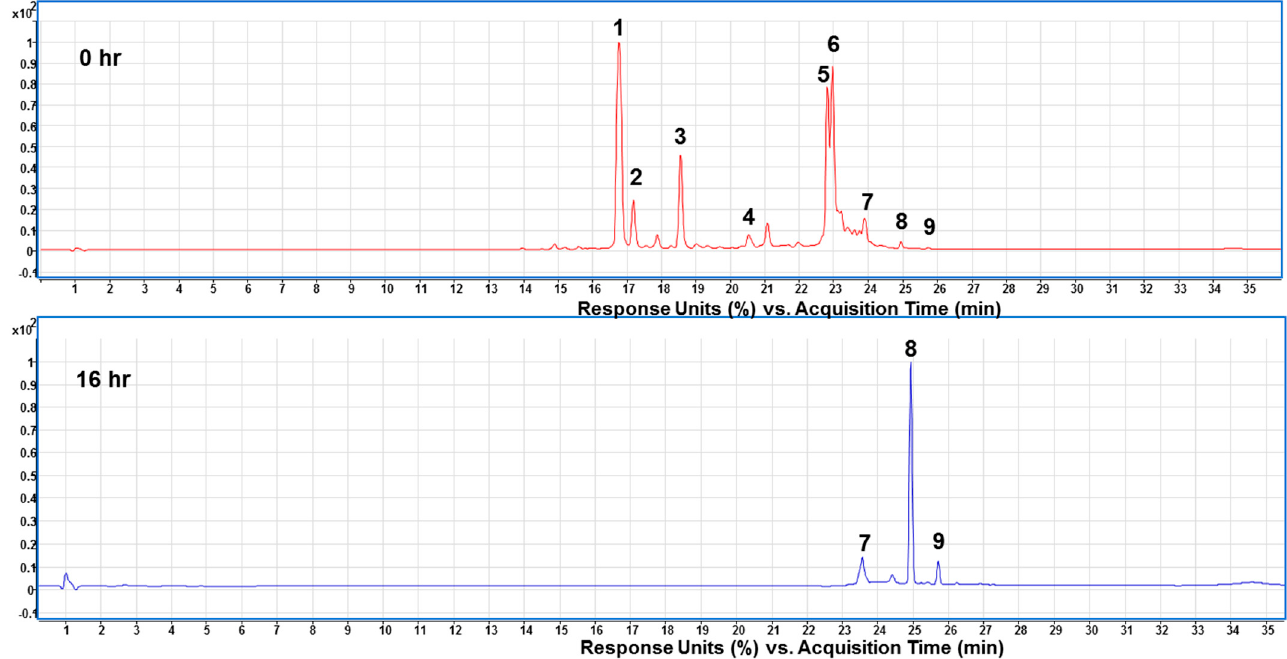
Figure 5. HPLC profiles for the bioconversion of crocins extracts using Celluclast ® 1.5 L enzymes detected at 440 nm in the incubation time of 0 and 16 h. HPLC parameters: C18 column (1.8 μ m, 2.1 × 100 mm; Agilent Eclipse Plus) column oven 35 °C, mobile phases ( A ) 0.1% formic acid in water and ( B ) acetonitrile (containing 0.1% Formic acid) at 0.3 mL/min. DAD: 440 nm. Peak numbers are referred to Table 3.